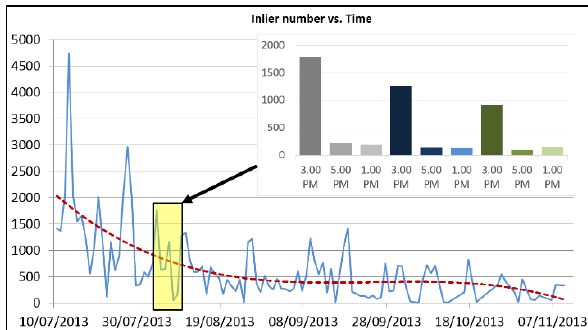
Figure 4: Inlier number at different epochs. On the upper right side the inlier number obtained at different time of the day is